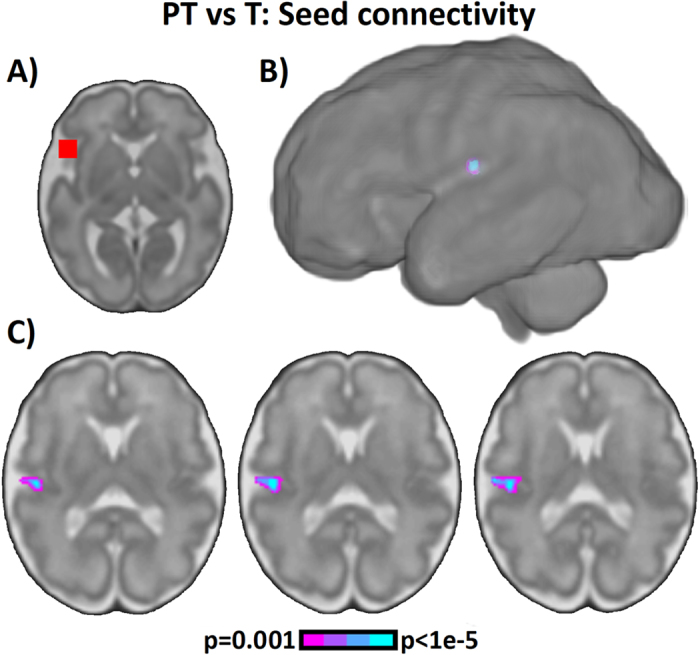
Comparison of preterm- and term-born fetuses using seed connectivity.(A) To investigate which specific connection may be driving our voxel-level ICD results, we performed follow-up seed connectivity using a cubic seed (shown in red) centered at the peak coordinate of between-group differences (27 mm left, 18 mm anterior, 5 mm inferior of the center of image data). (B) Significant differences (p < 0.05, corrected) between preterm- and term-born fetuses were observed in regions eventually becoming primary auditory cortex and Wernicke’s area as shown on (B) surface rendering and (C) axial slices. No regions exhibited increased seed connectivity for preterm-born fetuses compared to term-born fetuses.